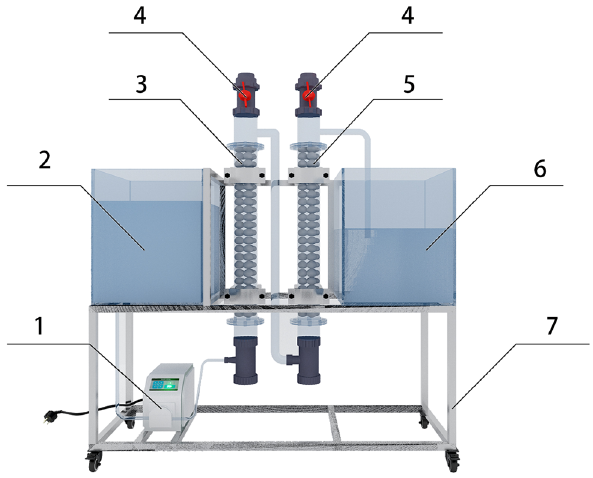
Figure 2: Schematic of the fi xed - bed reactor; 1 – fl ow - type peristaltic pump, 2 – in fl uent tank, 3 – reaction column, 4 – packing inlet/ outlet, 5 – packing pack, 6 – e ffl uent tank, 7 – fi xed - bed